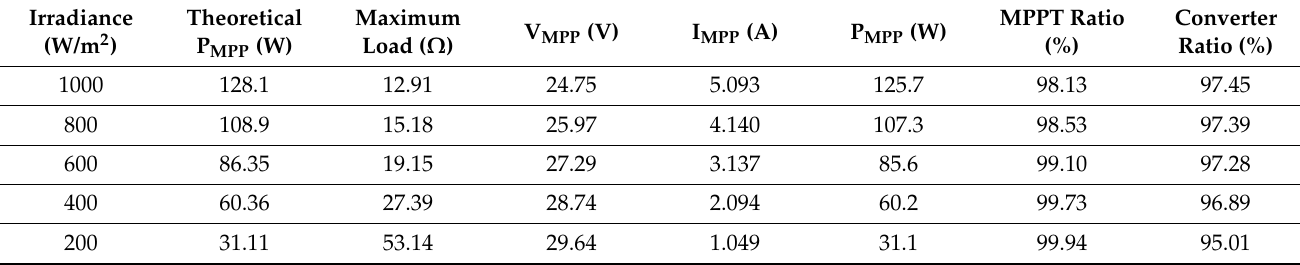
Table 5. Simulated MPPT test results at different irradiance